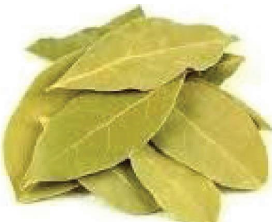
Figure 1: Bay laurel leaves ( Laurusnobilis